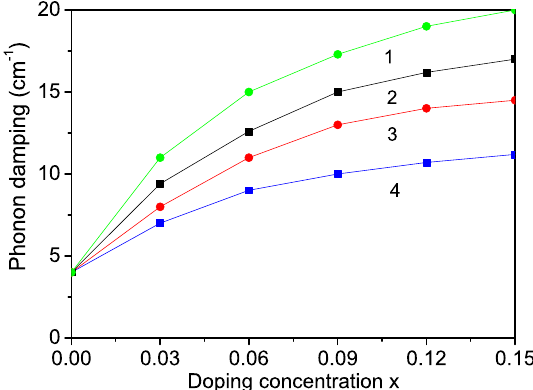
Figure 6. Doping concentration dependence of the phonon energy ω of a ZnS NP for N = 10 shells, T = 300 K and different doping ions: (1) Fe; (2) Co; (3) Dy; (4) Nd.